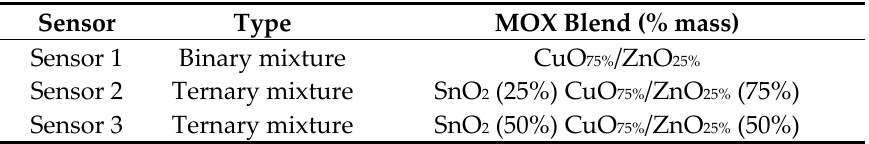
Table 1. The different sensors.